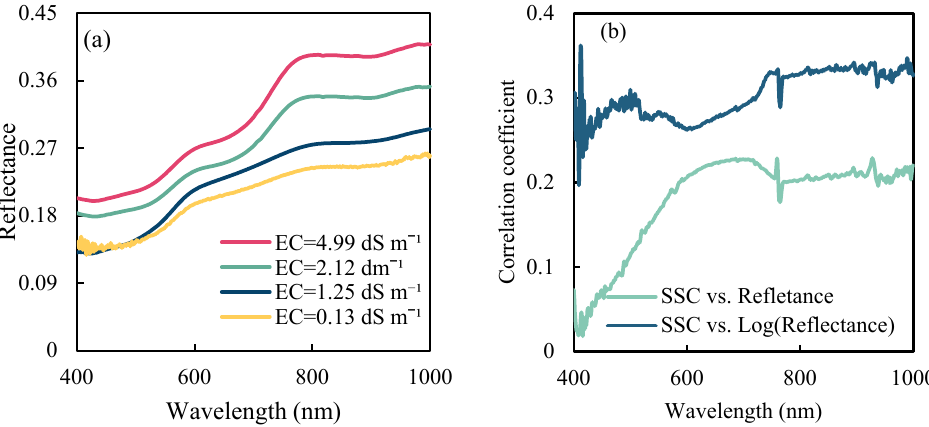
Figure 5. The relationship between SSC and spectral reflectance: ( a ) variation of spectral reflectance of soil with SSC with SMC 0.11 g g − 1 ; ( b ) correlation analysis of SSC with reflectance and log(reflectance), respectively.